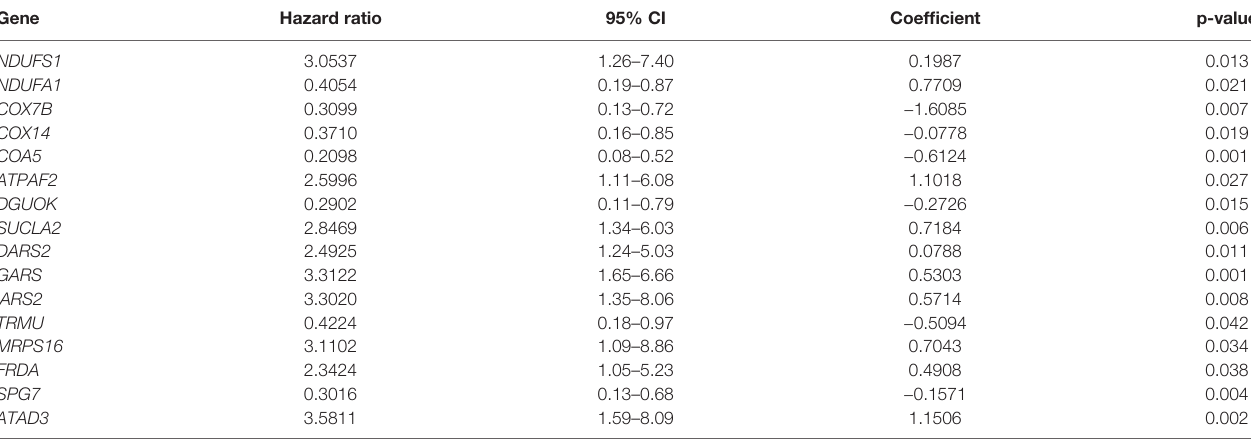
CI, con fi dence